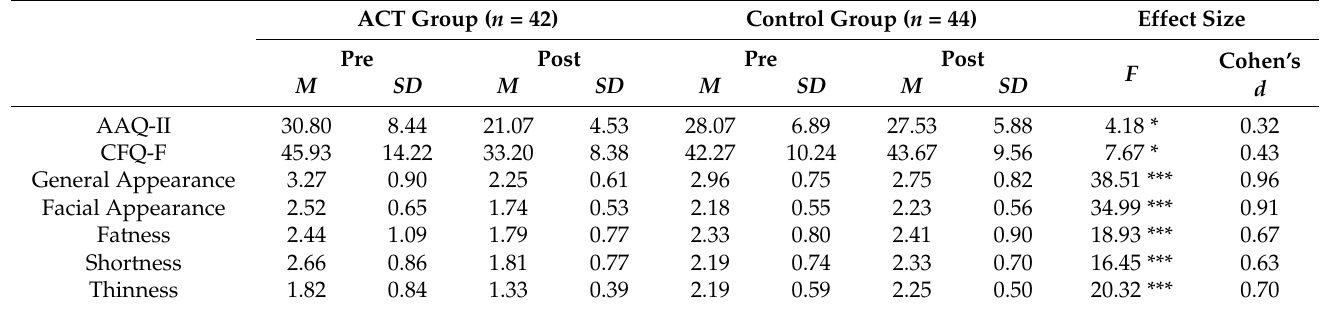
Table 4. Descriptive data at pretreatment and posttreatment, results of the one-way ANCOVA, and effect